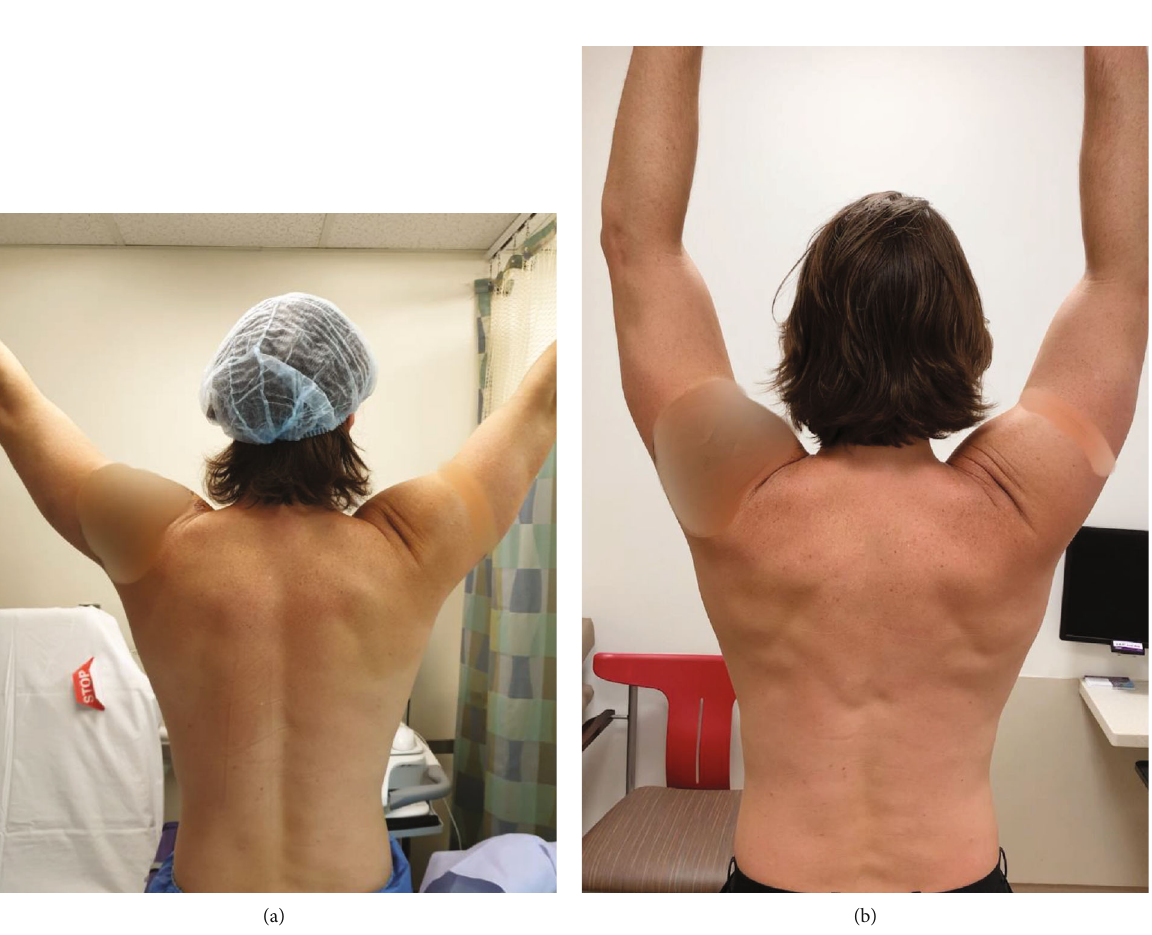
Figure 1: Clinical photographs: preoperative clinical photograph (a), six weeks after injury, demonstrating some residual left hemithoracic and axillary swelling with ecchymosis and a less conspicuous posterior axillary fold. Postoperative clinical photograph (b), one year after surgery, demonstrating symmetric contour of the left axillary fold and restoration of muscle bulk of the latissimus dorsi and teres